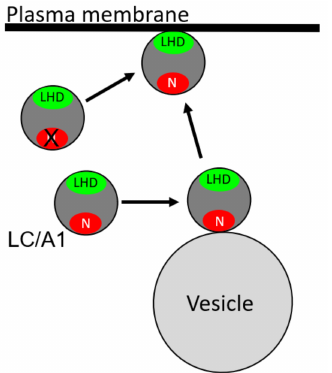
Figure 7. Model for the anterograde trafficking and localization of A1 to the plasma membrane. The N (red) of A1 associates with the extracellular surface of the vesicle; the LHD (green) allows A1 to efficiently associate with the plasma membrane. LHD transitions both soluble and vesicular-bound A1 to the plasma membrane independent of the N of A1, but transfers are more efficient when LC is